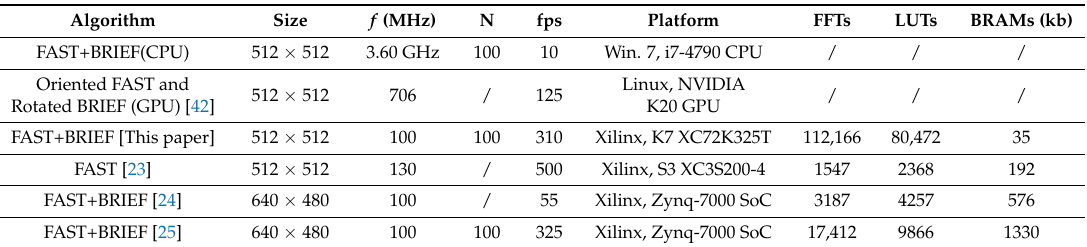
Table 2. Comparison between proposed method and PC/previous